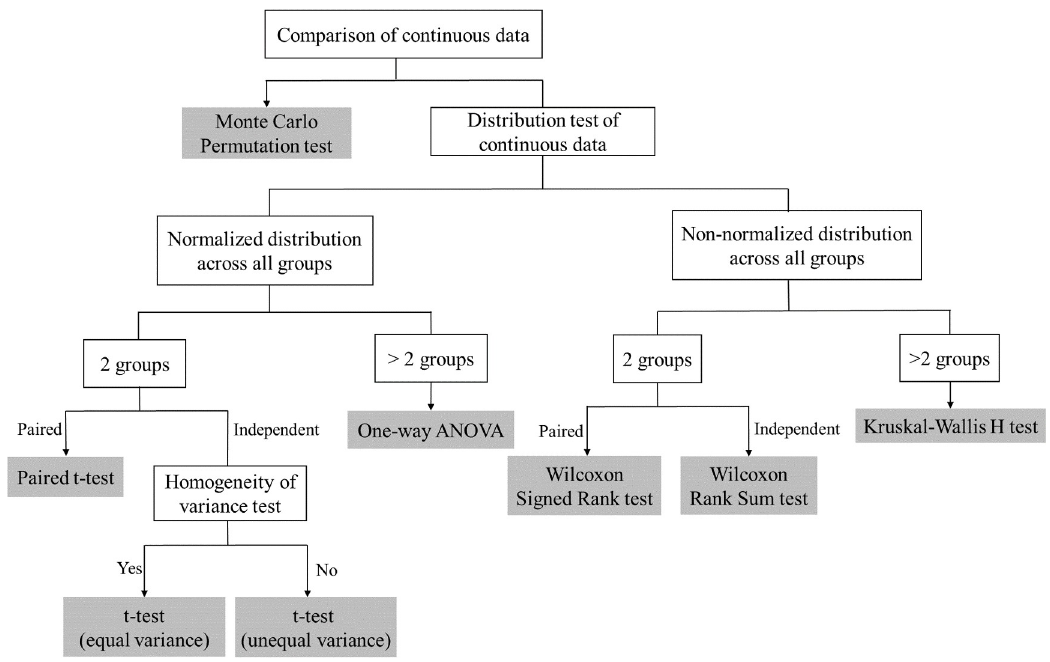
Fig 2. The selection of significance tests based on different